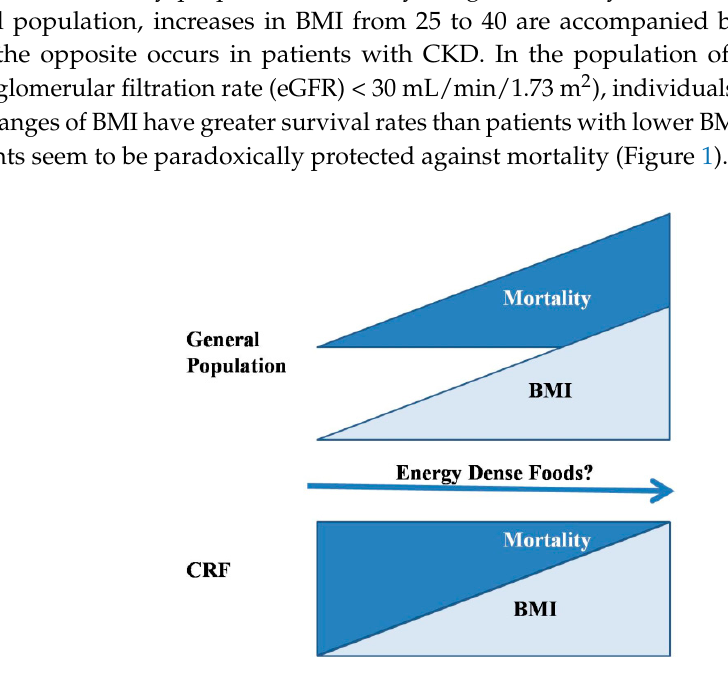
Figure 1. The obesity paradox. While in the general population, increases in body weight and body mass index (BMI) are directly correlated with mortality, in patients with chronic renal failure (CRF), an inverse correlation is observed. Since eating energy-dense foods is associated with increases in BMI, these diets are likely to result in increased mortality in the general population, but what is their effect in the CRF population?